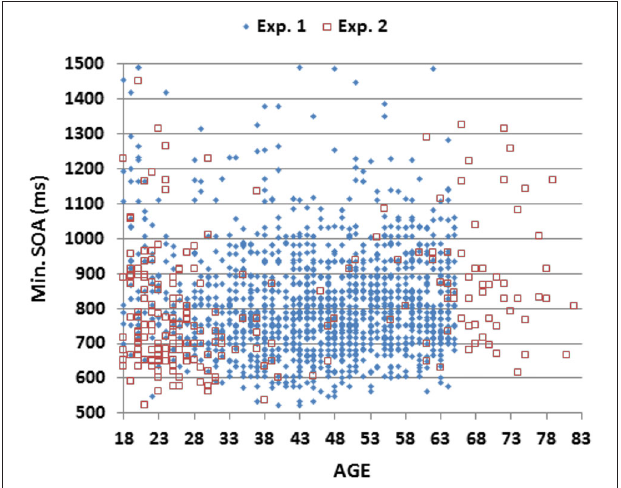
FIGURE 3 | Minimum stimulus onset asynchronies (mSOAs) . Shown as a function of age for subjects in Experiments 1 and 2.